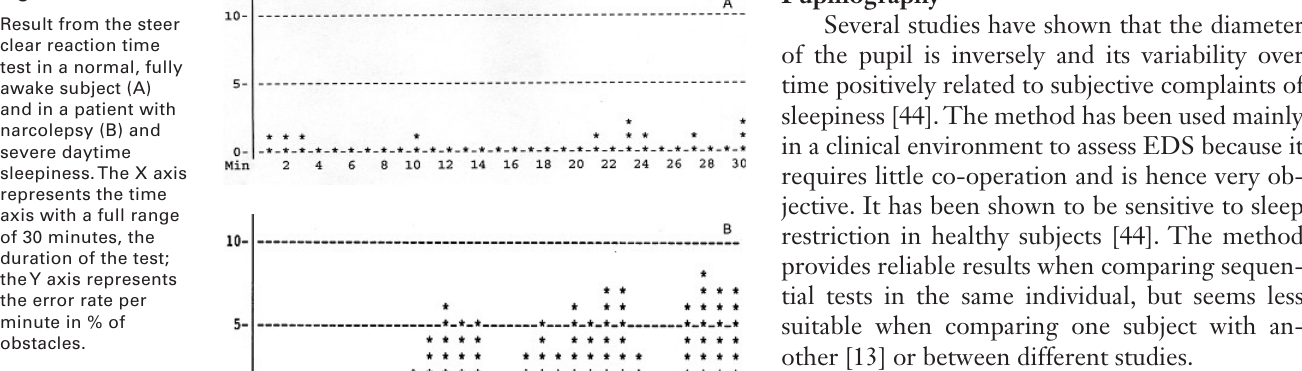
Result from the steer clear reaction time test in a normal, fully awake subject (A) and in a patient with narcolepsy (B) and severe daytime sleepiness.The X axis represents the time axis with a full range of 30 minutes, the duration of the test; theY axis represents the error rate per minute in % of